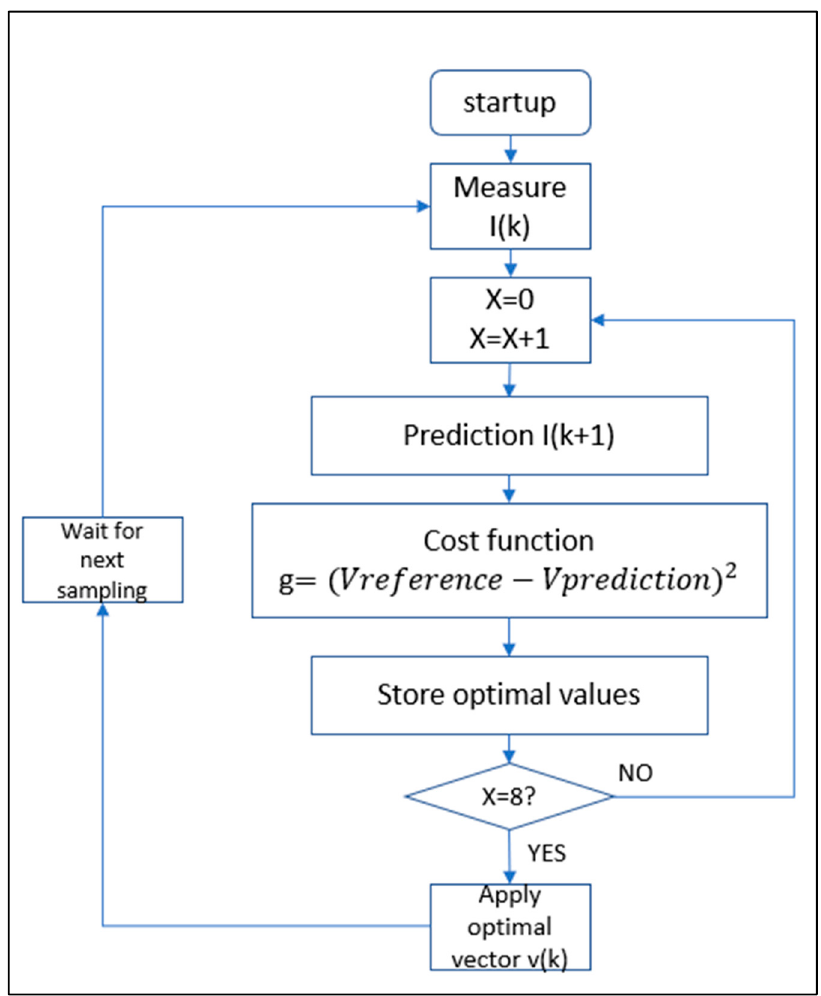
Figure 14. Flowchart of predictive current control.